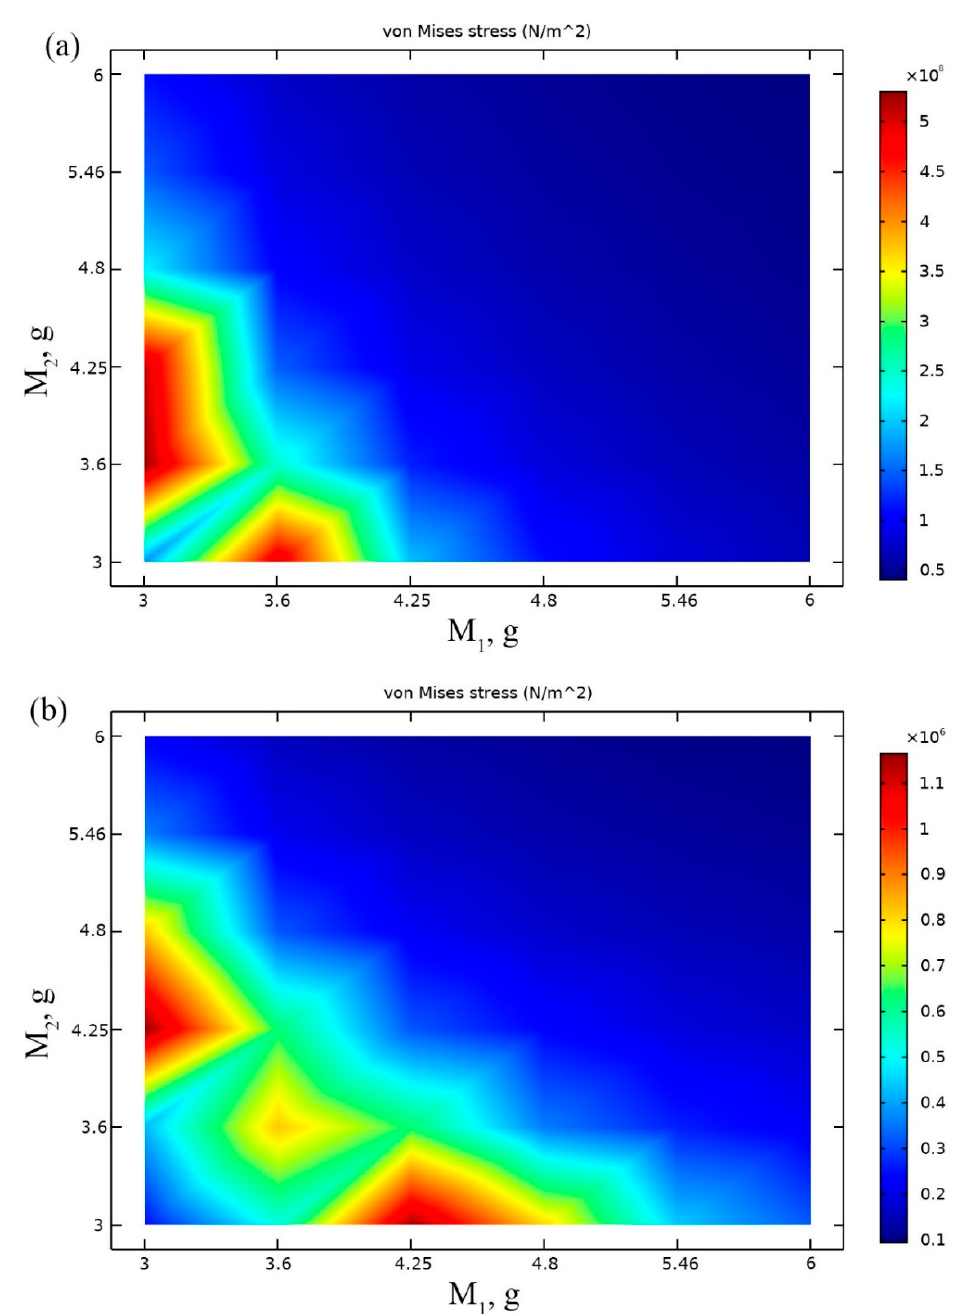
Figure 4. Plot of von Mises stresses at the resonance frequency when different M 1 and M 2 are used: acceleration aligned to z direction, resonant frequency 15 Hz ( a ); acceleration aligned to y direction, resonant frequency 28 Hz ( b ).